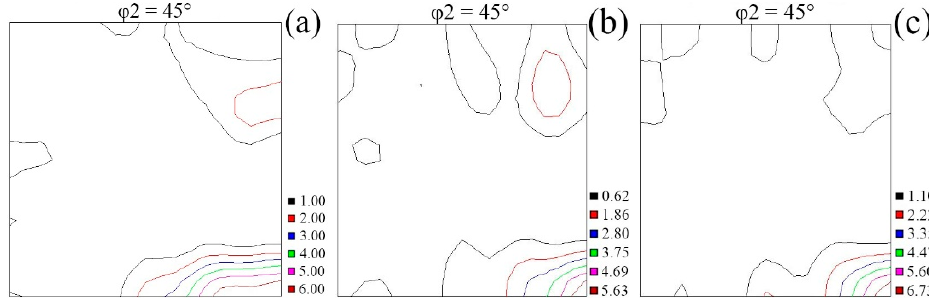
Figure 11. EBSD center IPF orientation maps of samples rolled with different reduction rates ( a ) 800 °C—78%, ( b ) 750 °C—78%, ( c ) 700 °C—78%.